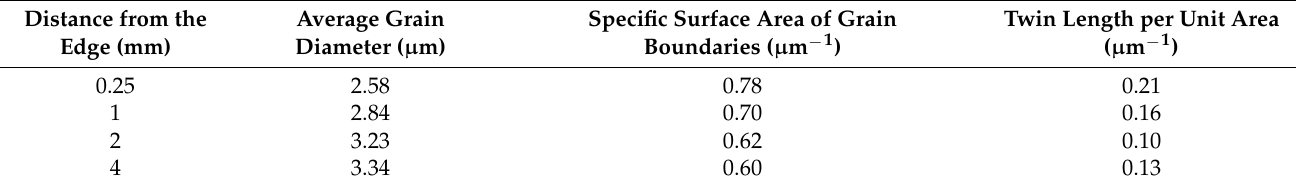
Table 2. The average grain diameter, specific surface area of grain boundaries and twin length per unit area after FCE at 150 ◦ C. Distance from